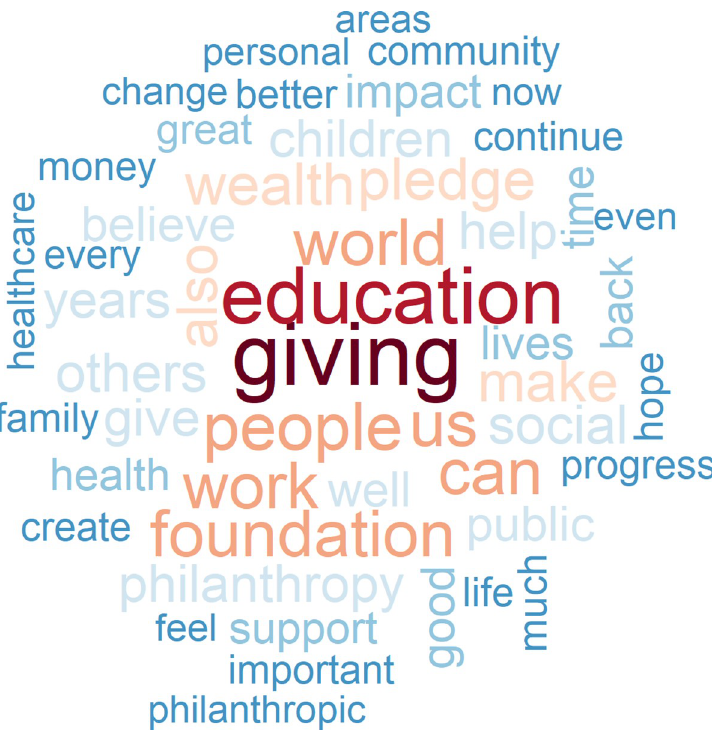
Fig 7. The 50 most frequently used words in the commitment letters submitted to the giving pledge by the tech elite versus no tech elite.